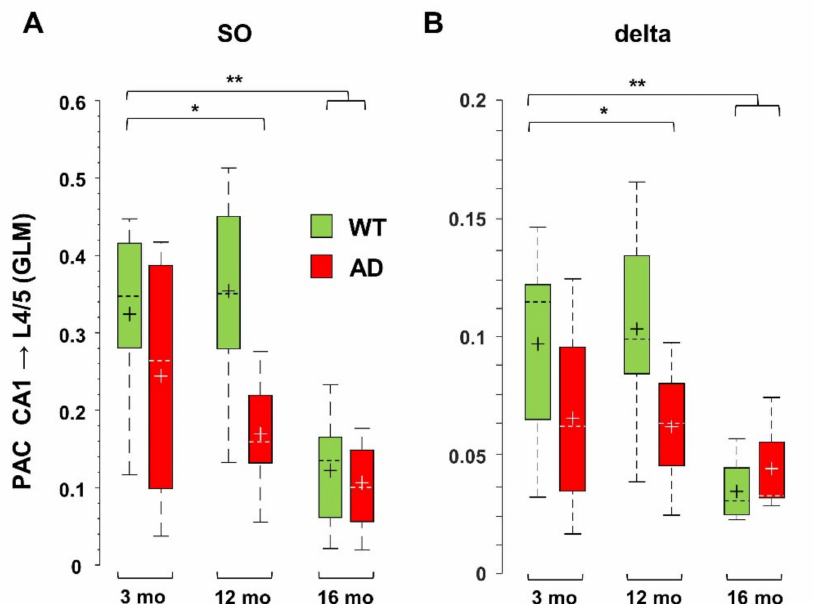
Figure 4. PAC based on SO and delta waves is reduced in middle-aged and old AD as well as in old WT mice. PAC, i.e., the coupling between amplitude of low frequencies and phase of higher frequencies, is measured by the GLM index, as described in Supplementary Materials. Significant reduction was found for PAC occurring between SO ( A ) or delta ( B ) bands in CA1 ( sr-lm , 1500 µ m) and FG in L4/5 (600 µ m) of the PPC, * p < 0.05; ** p <